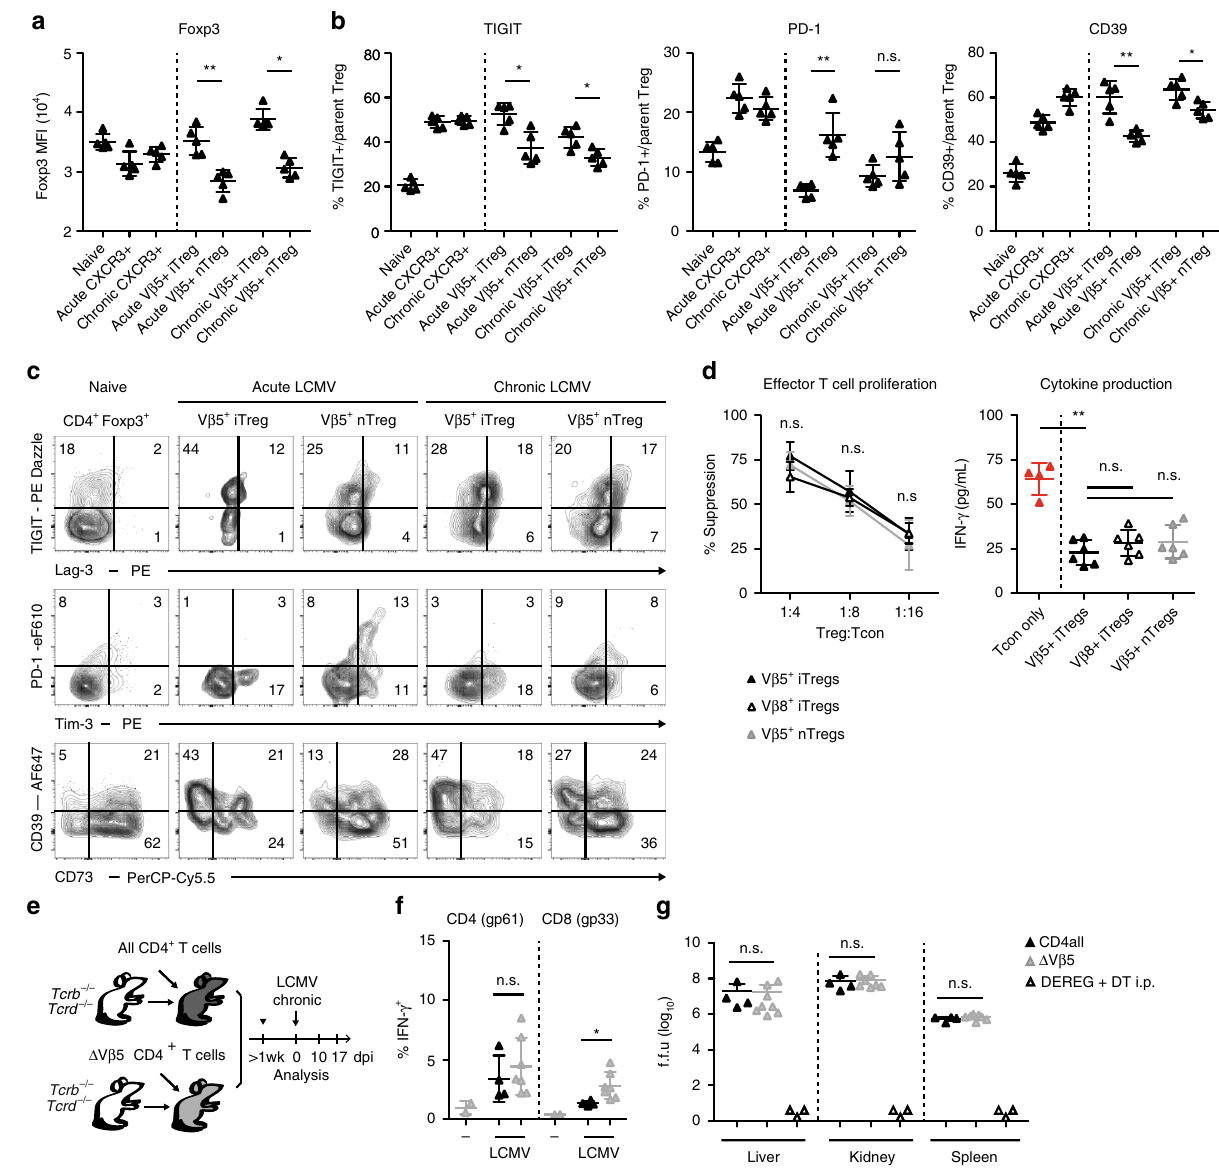
Fig. 2 V β 5 + Treg cells are suppressive but not required for regulating anti-viral immunity. Foxp3 -GFP.KI mice were infected with 200 f.f.u. LCMV WE (acute), 10 6 f.f.u. LCMV clone 13 (chronic), or were left naïve. a – c Mean fl uorescence intensity (MFI) of Foxp3 -GFP expression and frequencies of TIGIT + , PD-1 + , Lag-3 + , Tim3 + , CD39 + , and CD73 + cells among the indicated CD4 + Foxp3 + subsets were determined on day 14 post infection using fl ow cytometry ( n = 5). d Foxp3 -GFP.KI mice were infected with 200 f.f.u. LCMV WE and fl ow sorted Foxp3 + CXCR3 + Nrp1 − V β 5 + ( fi lled), Foxp3 + CXCR3 + Nrp1 − V β 8 + (open) or Foxp3 + CXCR3 + Nrp1 + V β 5 + (grey) Treg cells were titrated onto CD4 + Foxp3 − effector T cells stimulated with anti-CD3 in the presence of irradiated APCs. Proliferation (left, n = 3 technical repeats) determined by [ 3 H]-thymidine incorporation and IFN- γ secretion into supernatants (right, Treg:Tcon = 1:4) determined by cytometric bead array were measured after 72 h (mean ± SD, n = 4 – 6, pooled data of three independent experiments). e Scheme for TCR-de fi ned CD4 T cell reconstitution. f , g Mice generated as outlined in e were infected with 10 6 f.f.u. LCMV clone 13 ( n = 2 – 7). f On day 17 splenocytes were restimulated with gp61 + gp33 LCMV peptides for 4 h and analyzed for IFN- γ production by fl ow cytometry. g Viral titers of the indicated organs were determined on day 17 post infection. DEREG mice depleted of Treg cells by diphtheria toxin treatment (day 4, 6, 8, 10, 12; n = 3) and analyzed for viral titers on day 14 were included as controls. Data are shown as mean ± SD; plots display one representative of >3 independent experiments. For statistics, Mann – Whitney U was